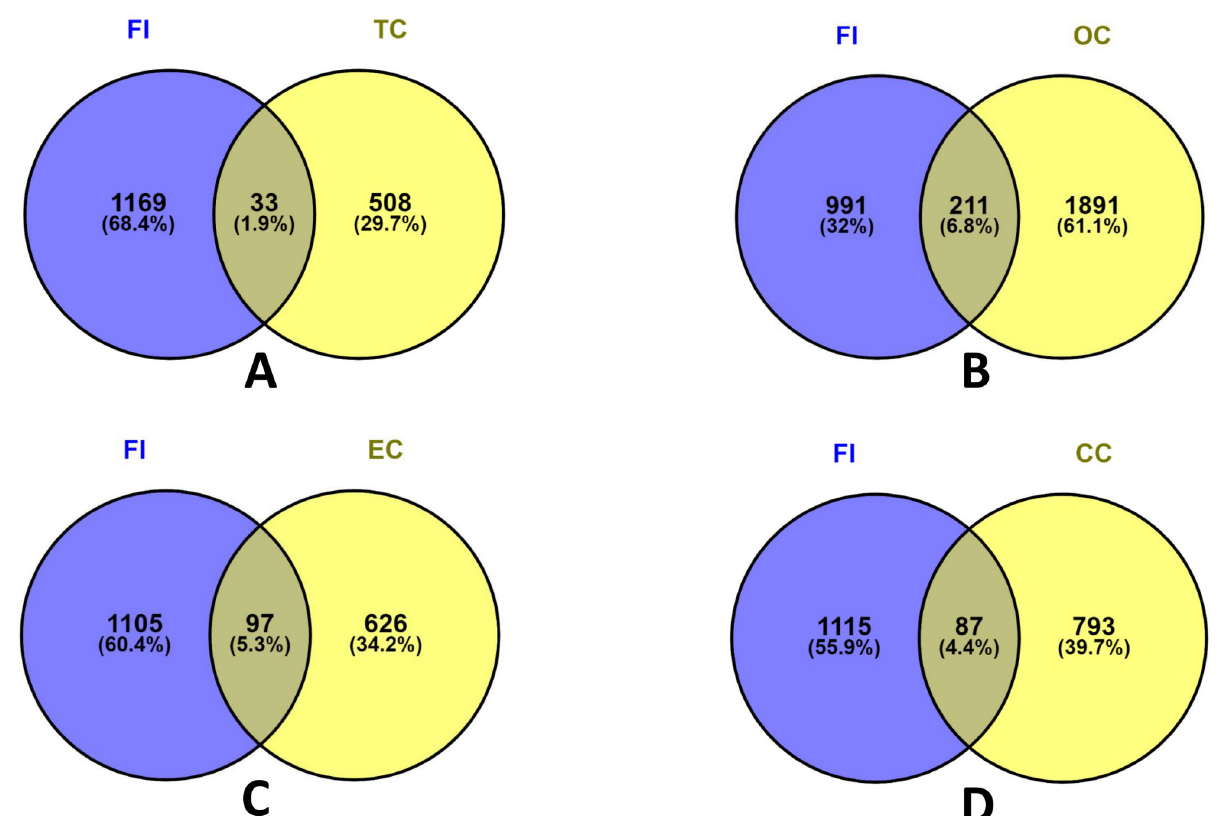
Fig 2. Venn diagram was applied to present all candidate targets of Female Infertility (FI) and four cancerous risk factors, where FI shared a common dysregulated gene between A. Thyroid cancer (TC), B. Ovarian cancer (OC), C. Endometrial cancer (EC), and D. Cervical cancer